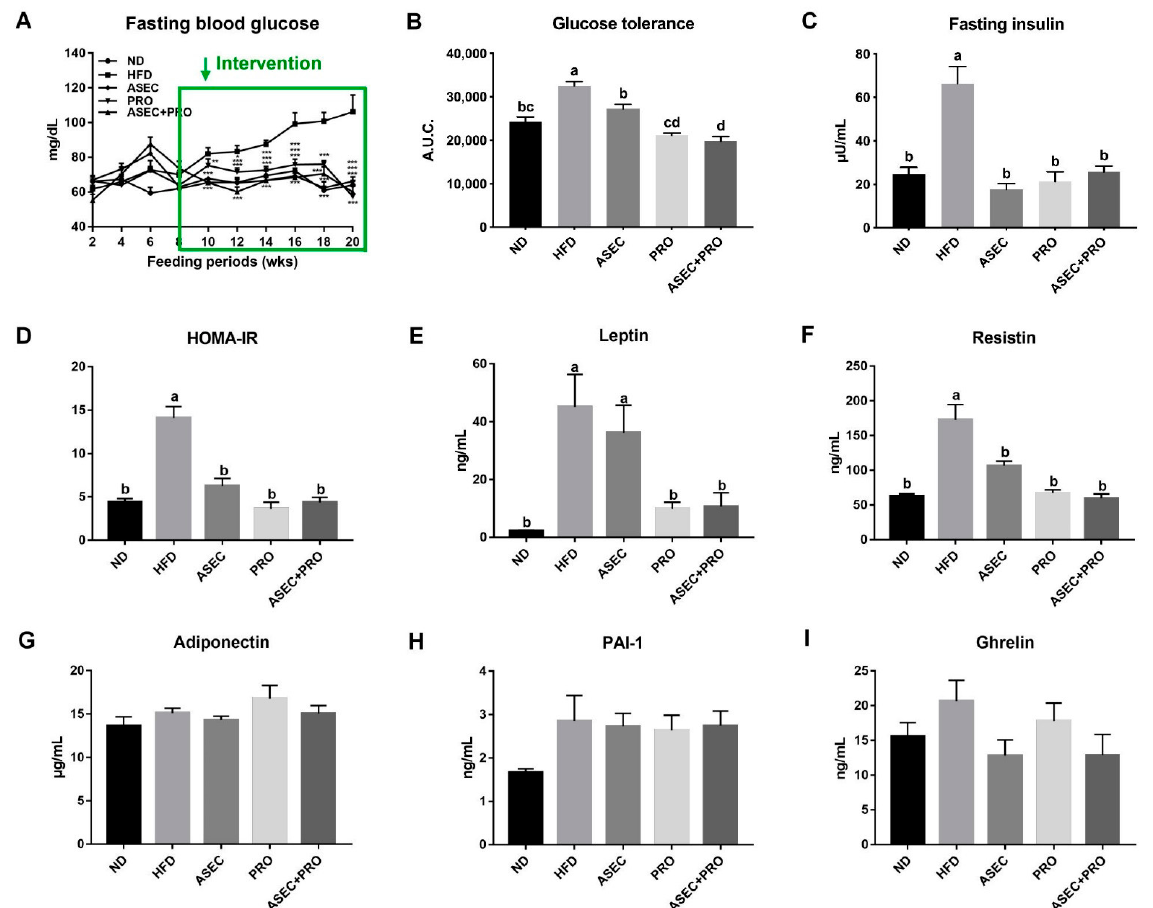
Figure 2. Intervention with ASEC, PRO, or ASEC + PRO improved impaired glucose intolerance, insulin resistance, and related pathophysiological indicators in HFD-induced obese mice. ( A ) Fasting blood glucose. Fasting blood glucose was measured by a glucose analyzer biweekly. ( B ) Assessment of glucose tolerance using intraperitoneal glucose tolerance tests (IPGTTs). Glucose was intraperitoneally injected at a concentration of 1.0 g/kg body weight and the glucose levels were measured by tail vein sampling. ( C ) Fasting insulin levels. Insulin Ultra-Sensitive kits were used for measurement. ( D ) The homeostasis model assessment of insulin resistance index (HOMA-IR). HOMA-IR was calculated as [fasting insulin (µU/mL) × fasting glucose (mg/dL) × 0.05551]/22.5. Levels of serum leptin ( E ), resistin ( F ), adiponectin ( G ), PAI-1 ( H ), and ghrelin ( I ) were determined by Luminex multiplex systems. Data ( n = 8) are expressed as the mean ± SEM. Statistical significance ( p < 0.05) is indicated by different letters (e.g., a, b). * p < 0.05, ** p < 0.01, *** p < 0.001.